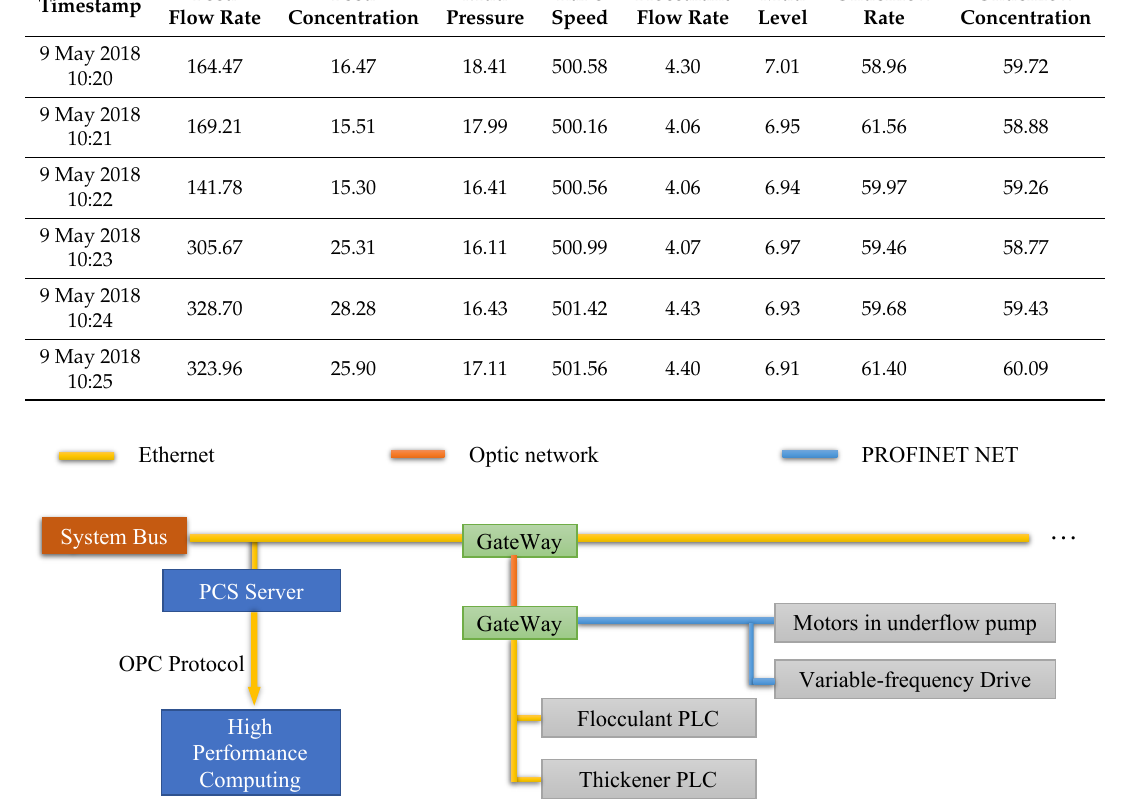
Figure 4. The topology graph of each devices and servers in the industrial case. We delete some components in the graph which are not related to our problem, such engineer station, operator station, etc. Historical database and prediction program are all deployed in high-performance computing